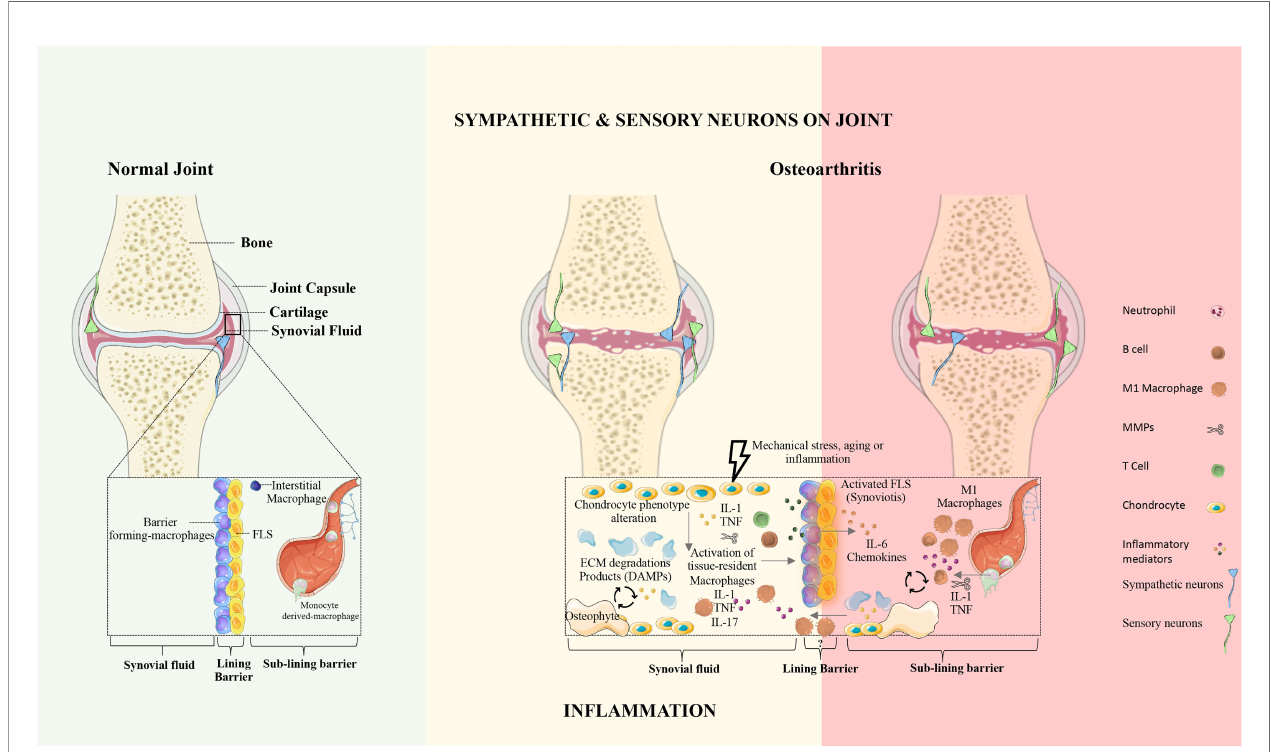
FIGURE 1 | The synovial joint in health and osteoarthritis. Normal joint: In the healthy joint, the synovium is formed by two layers, the lining and the sub-lining. The lining layer is composed of barrier-forming macrophages and fi broblast-like synoviocytes (FLS). The sub-lining layer is composed of fi broblasts, tissue-resident macrophages, nerves, and blood vessels. In physiologic conditions, the articular cartilage is not innervated and does not contain blood vessels. Osteoarthritis: OA is characterized by articular damage and osteophyte formation. The presence of speci fi c cell subsets and in fl ammatory mechanisms in OA remains unclear. In OA the innervation pro fi le is closely linked to in fl ammatory severity. FLS, fi broblasts-like synoviocytes; ECM, extracellular matrix; DAMPs, damage-associated molecular patterns; IL, Interleukin; TNF, Tumor necrosis